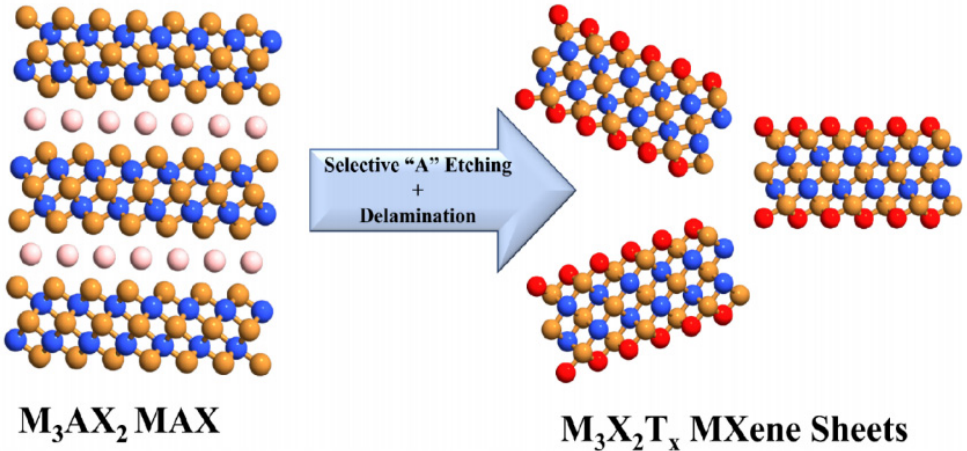
Figure 4. Schematic illustration of MXene synthesis. Reprinted with permission from [52]. Copyright © 2021, American Chemical Society, CC-BY-NC-ND 4.0 license.